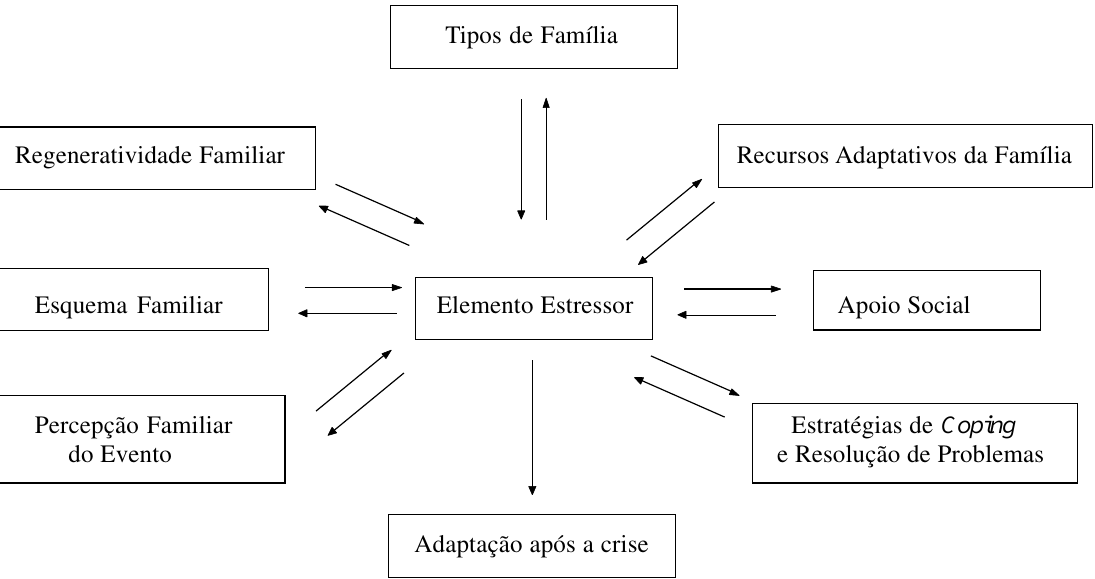
Figura 1 . Modelo de estresse e adaptação